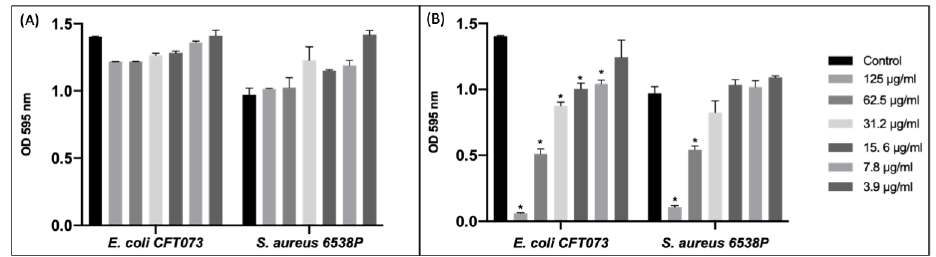
Figure 5. Susceptibility test with empty niosomes ( A ) and CIP-loaded niosomes ( B ). Data were expressed as mean ± SD. All considered conditions were compared to untreated control. * p value ≤ 0.05.